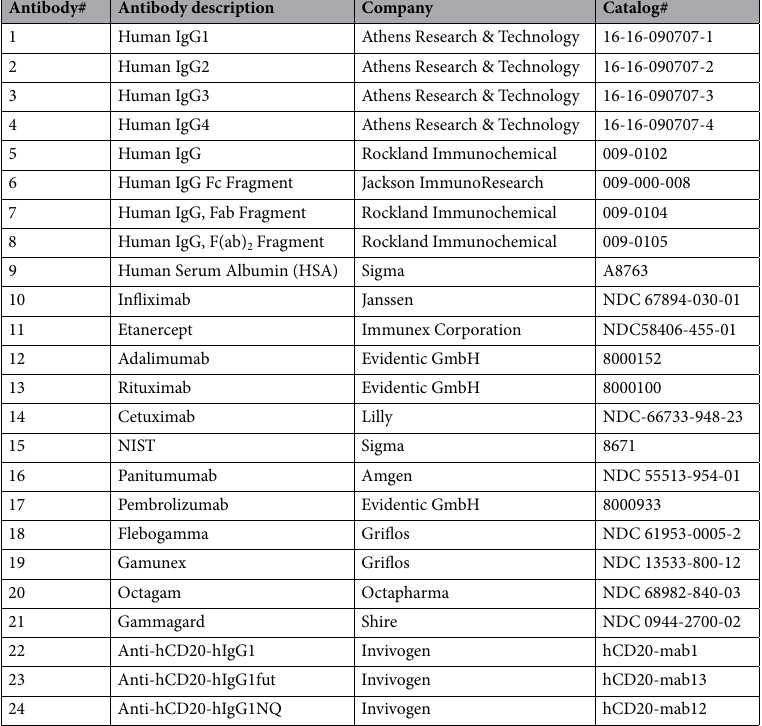
Table 1. List of antibodies used in this